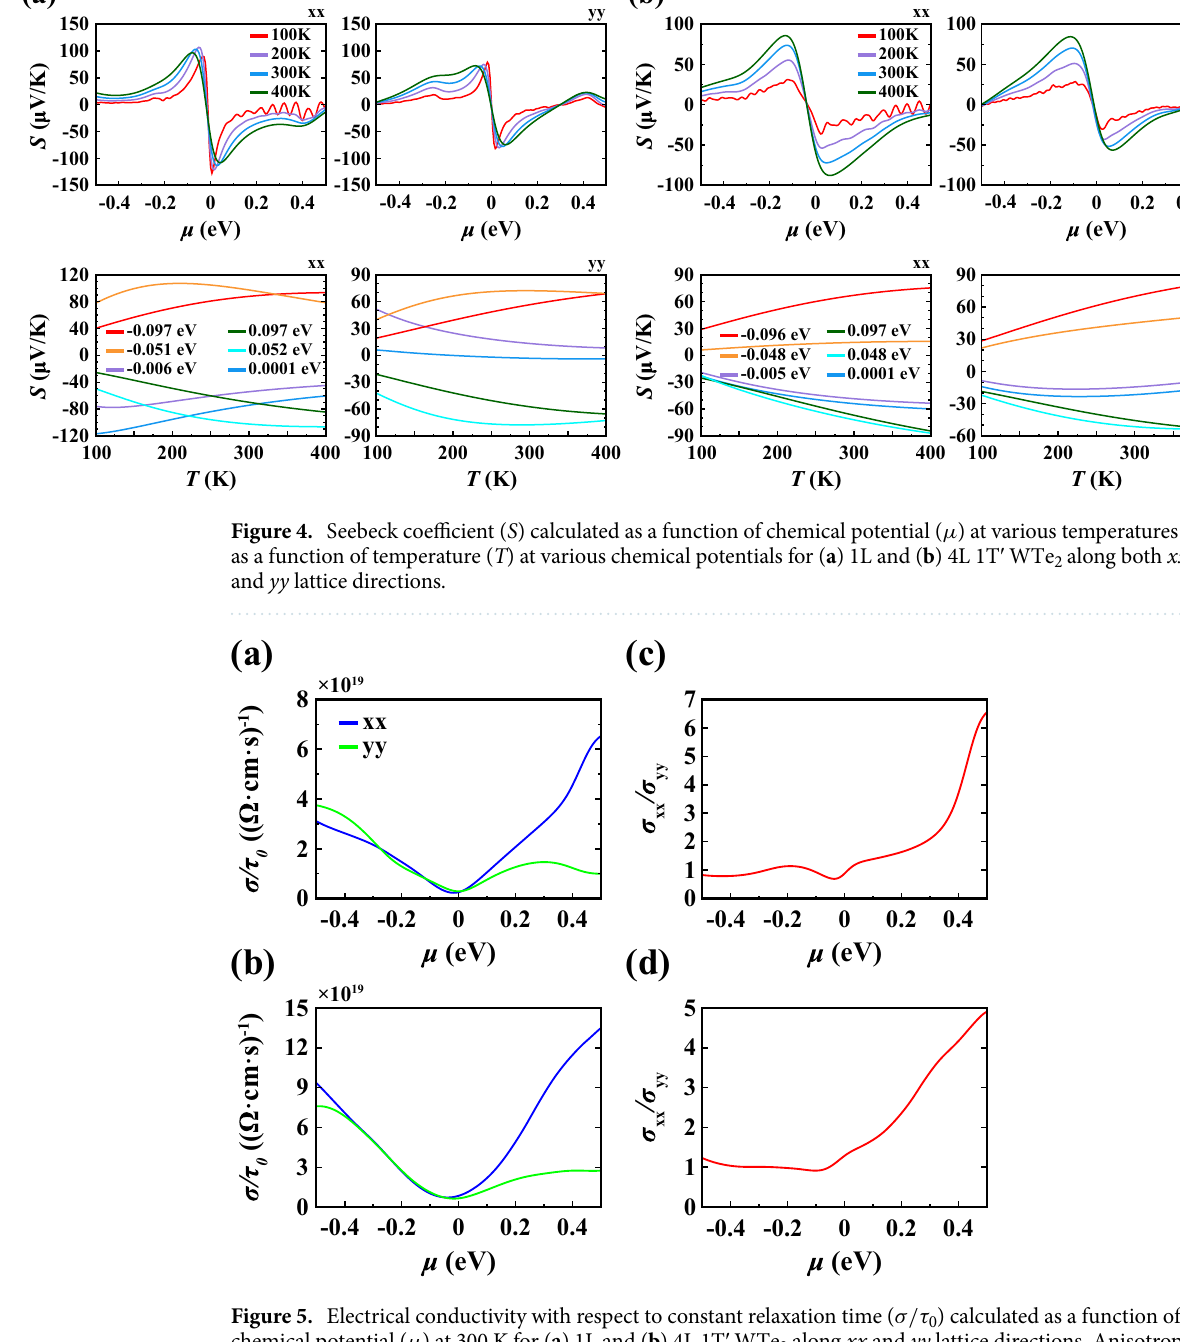
Figure 5. Electrical conductivity with respect to constant relaxation time ( σ/τ 0 ) calculated as a function of chemical potential ( µ ) at 300 K for ( a ) 1L and ( b ) 4L 1T ′ WTe 2 along xx and yy lattice directions. Anisotropy factor σ xx /σ yy of electrical conductivity for ( c ) 1L and ( d ) 4L 1T ′ WTe 2